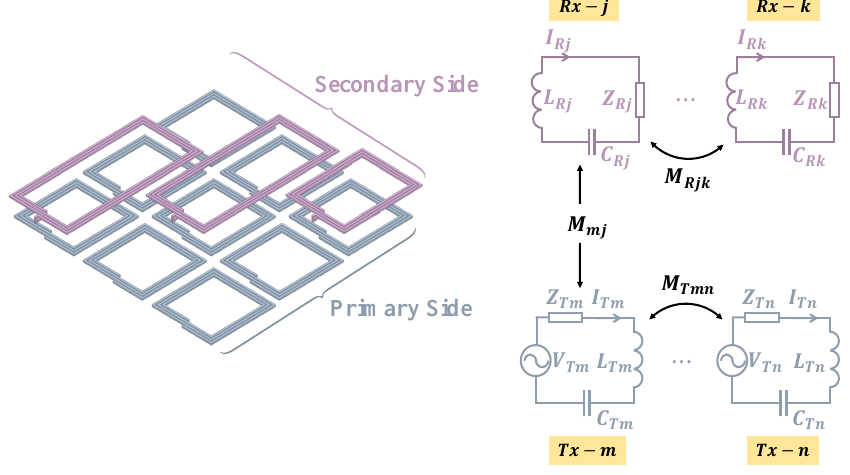
Figure 1. The configuration of n × k magnetic resonant WPT